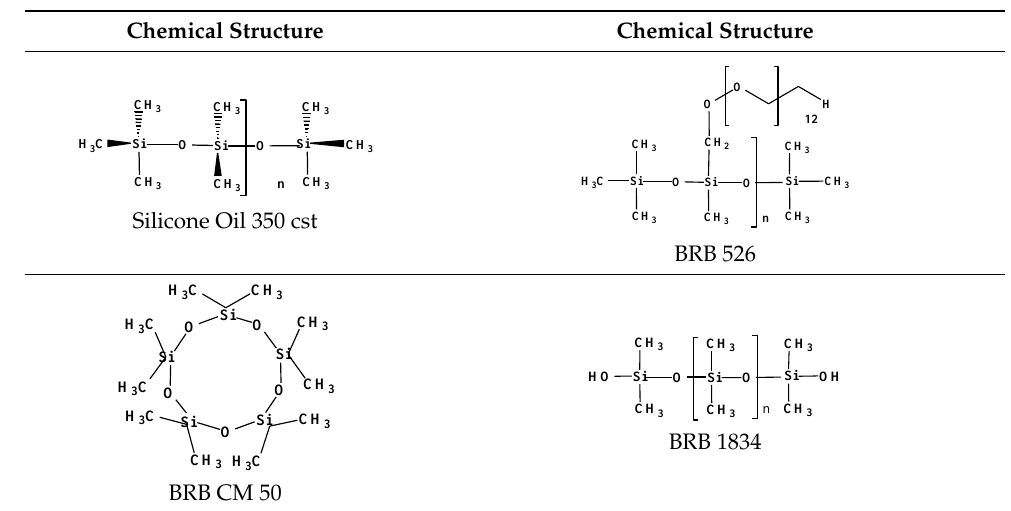
Table 1. Chemical structure of polyorganosiloxanes.